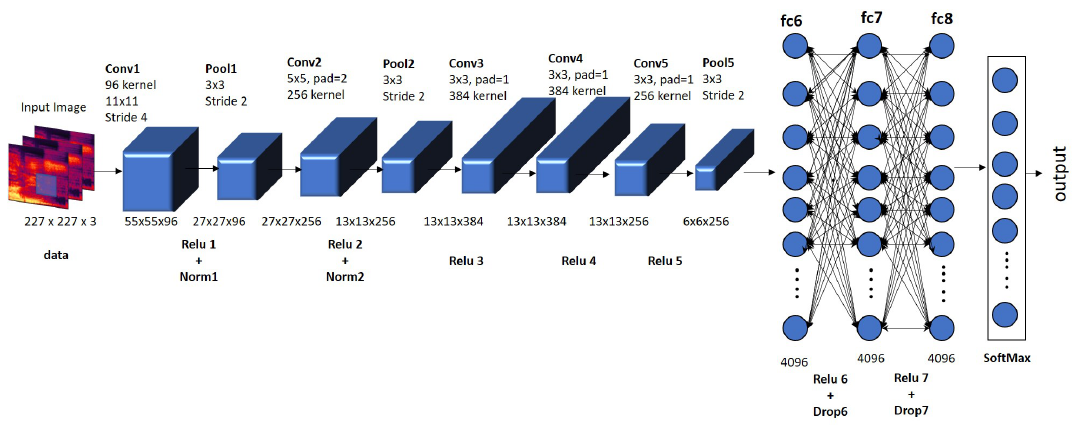
Figure 7. AlexNet